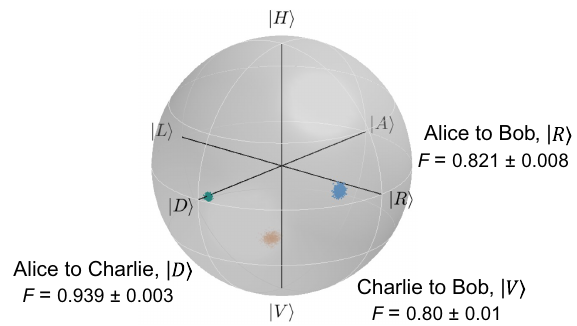
FIG. 6. Tomography results for qubit states remotely prepared on each logical